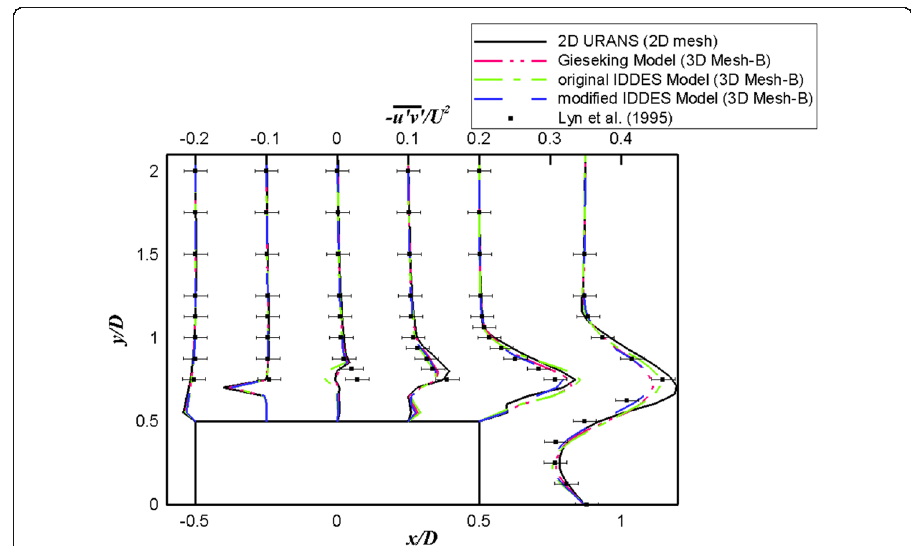
Fig. 6 Reynolds-averaged shear stress profile at different locations before wake predicted by simulations with URANS model and 3D